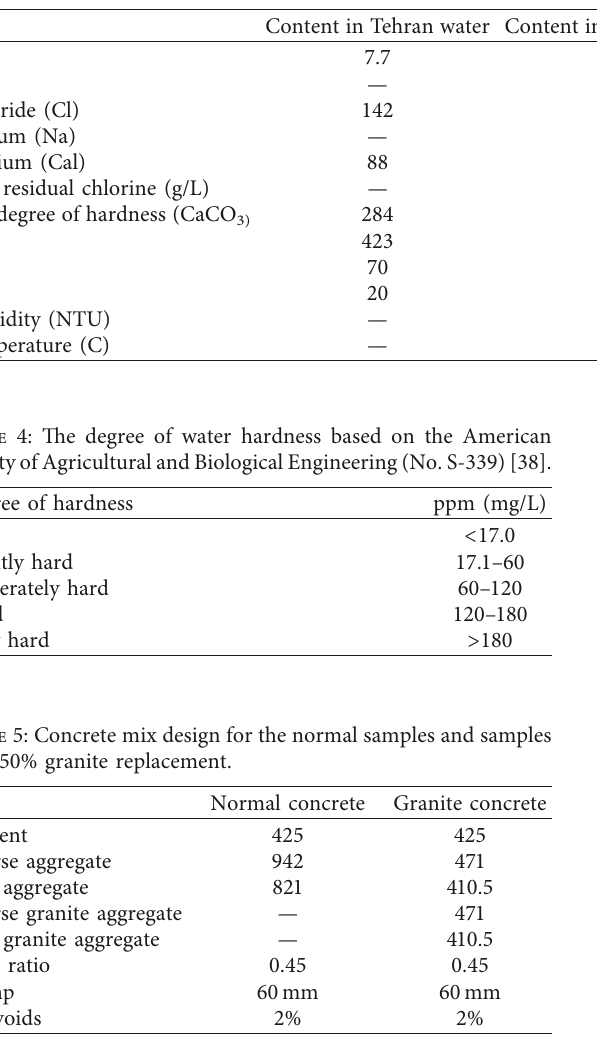
Table 3: Comparison of drinking water of Larestan and Tehran with the Iranian Water Standard. The unspecified parameters are shown by dashed cells [35, 36].